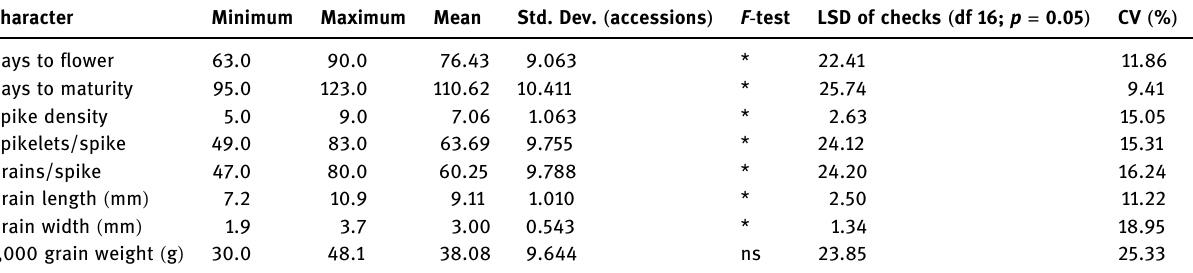
Table 3: Statistical parameters for the mean values of agro - morphological characters of 16 indigenous Omani barley USDA accessions over two years along with standard error ( SE ) and coe ffi cient of variation ( CV% ) for the analyses of fi ve check varieties ( r = 5 )